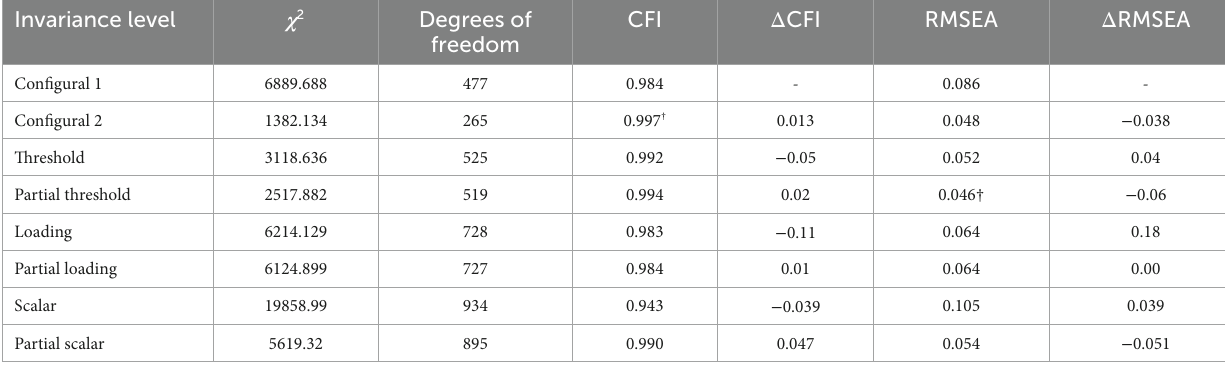
The configural model was just identified. TABLE 4 Global fit indices for different levels of measurement invariance of negative